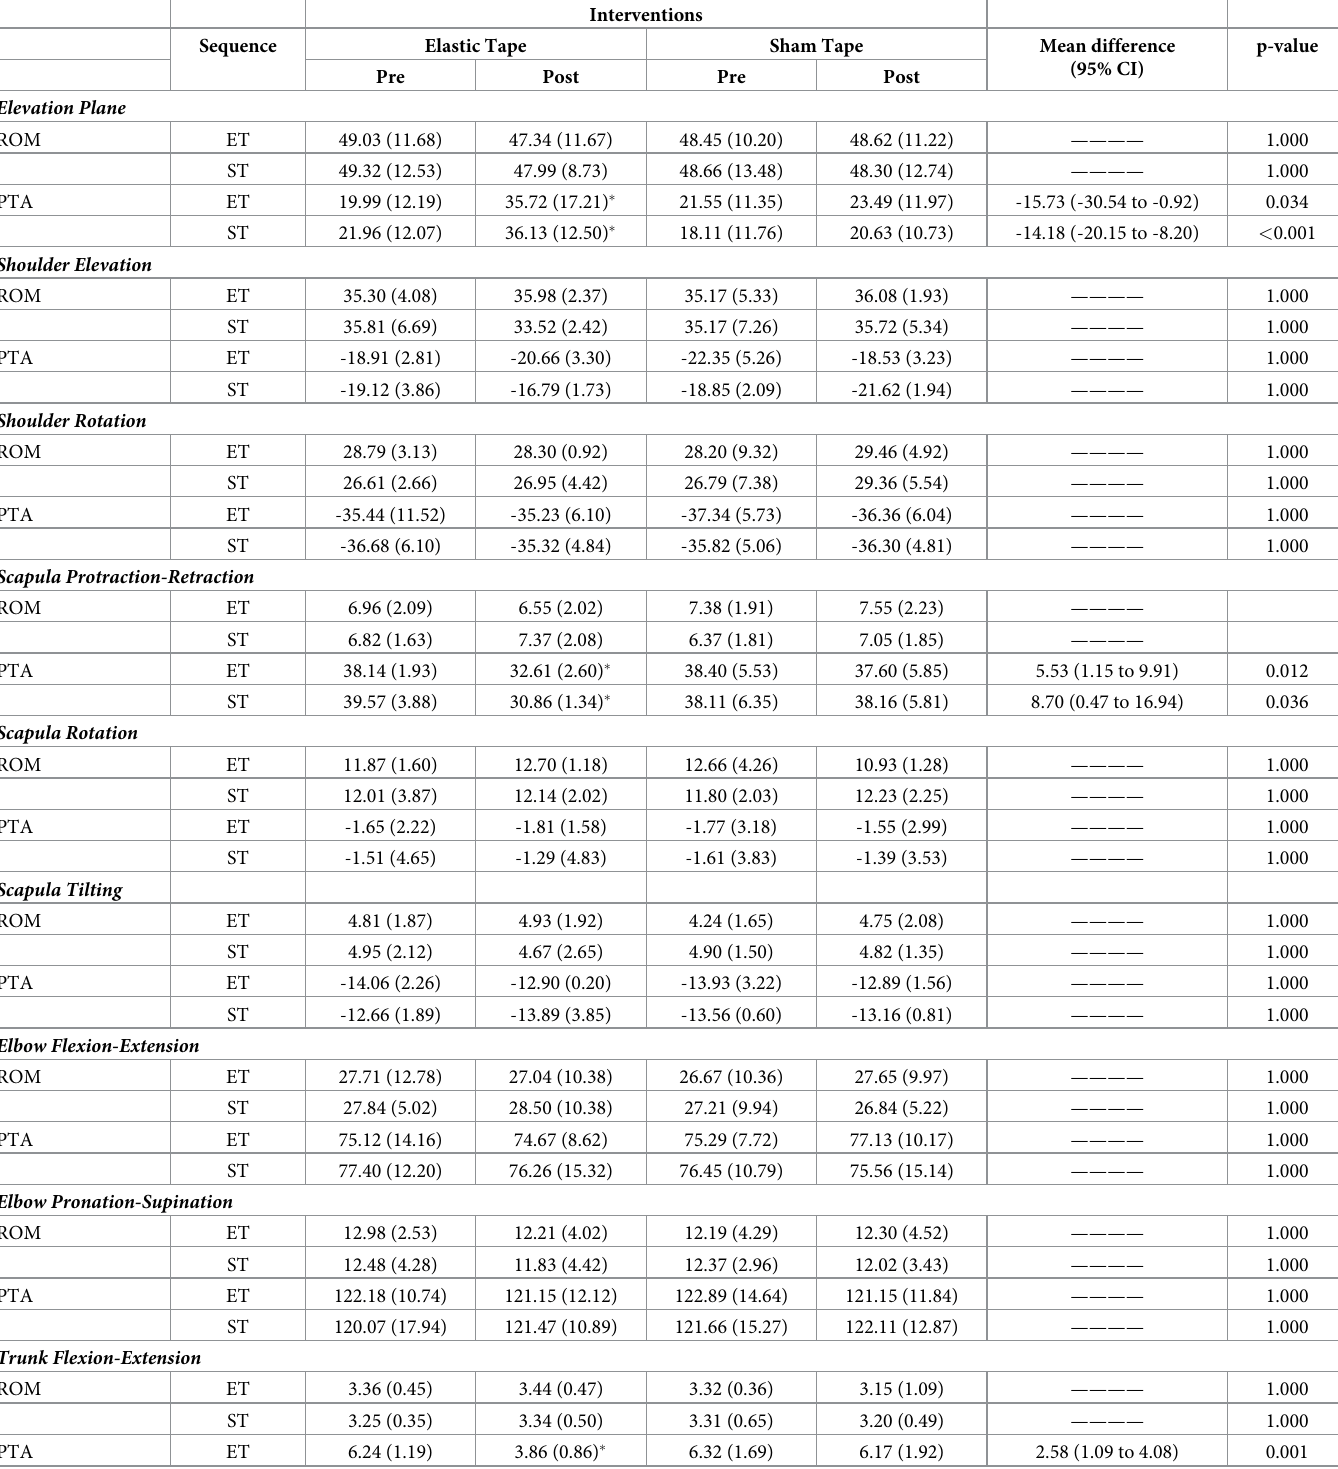
Table 4. ROM and PTA for all joints assessed while returning to the initial position for both sequences (groups: ET and ST) pre and post-interventions (elastic and sham tape).